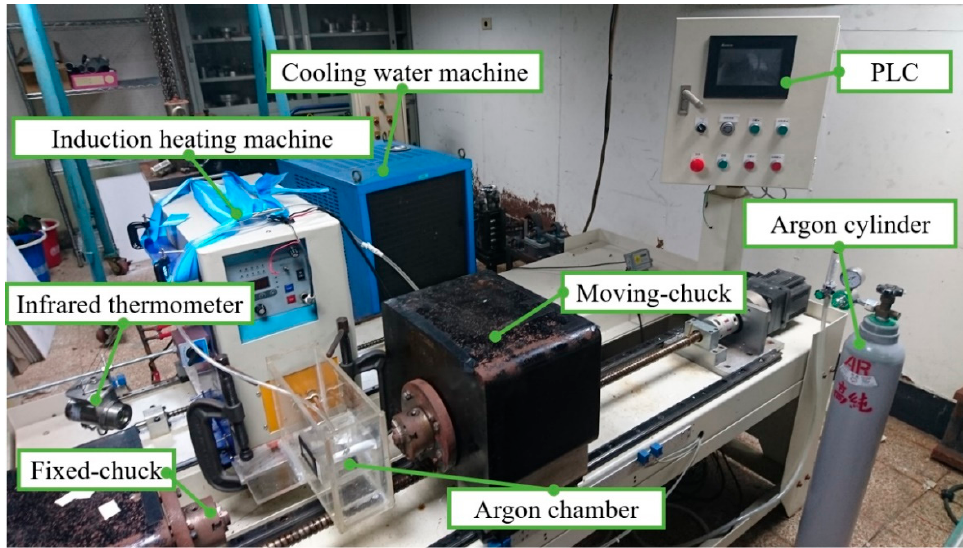
Figure 2. Layout of self-developed dieless drawing machine.